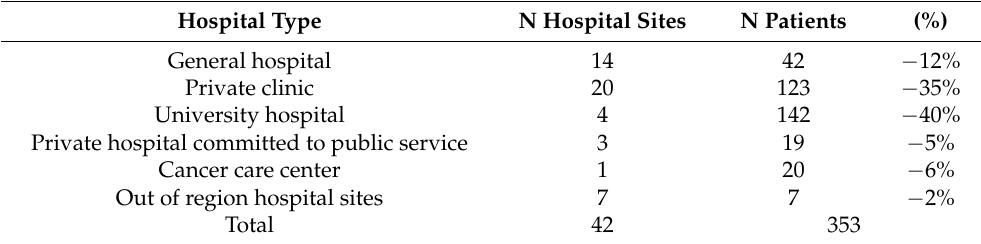
Table 2. Distribution of patients who underwent curative pancreatic surgery (group A) according to hospital structure type performing the surgical act.